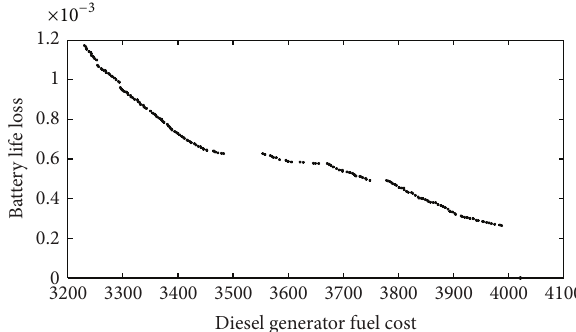
Figure 8: The daily water demand condition.